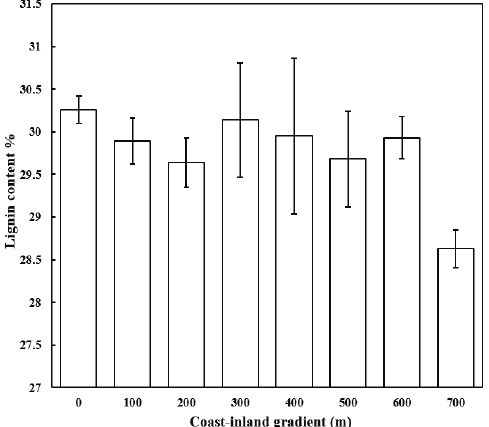
Figure A1. Variations in leaf lignin for P. thunbergii along the coast-inland